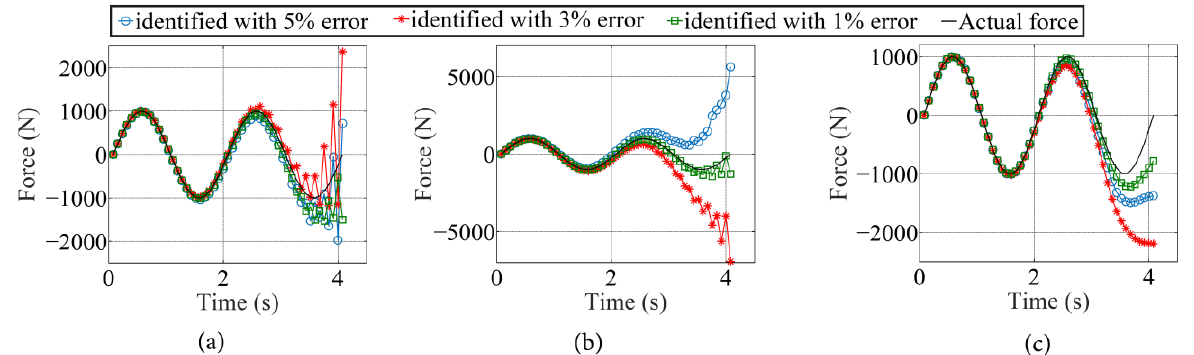
Figure 14. The identified load with one sensor and ( a ) no regularization, ( b ) γ = 10 − 22 , and ( c ) γ = 10 − 18 .